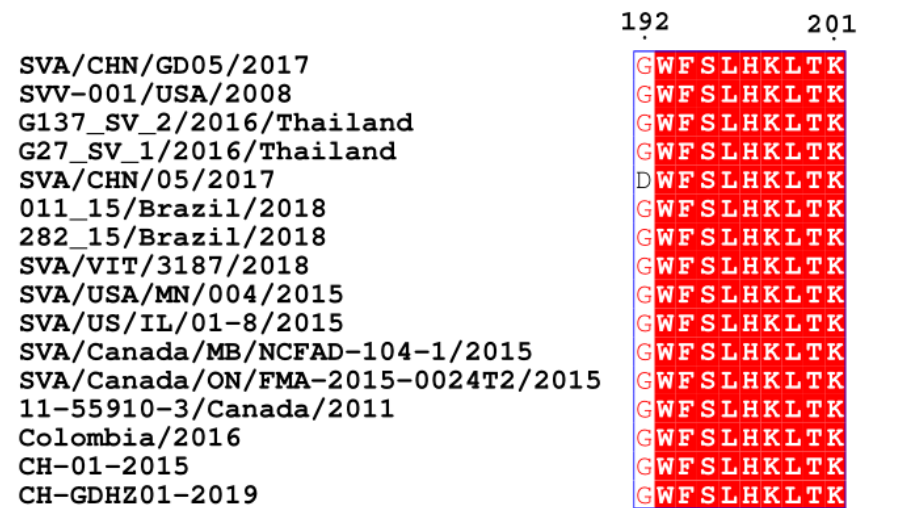
Figure 5. Comparison of the 192 GWFSLHKLTK 201 epitope amino acid sequence among different SVA strains. All SVA strains from GenBank were selected for sequence alignment using MAFFT. Sequences of representative strains are shown.